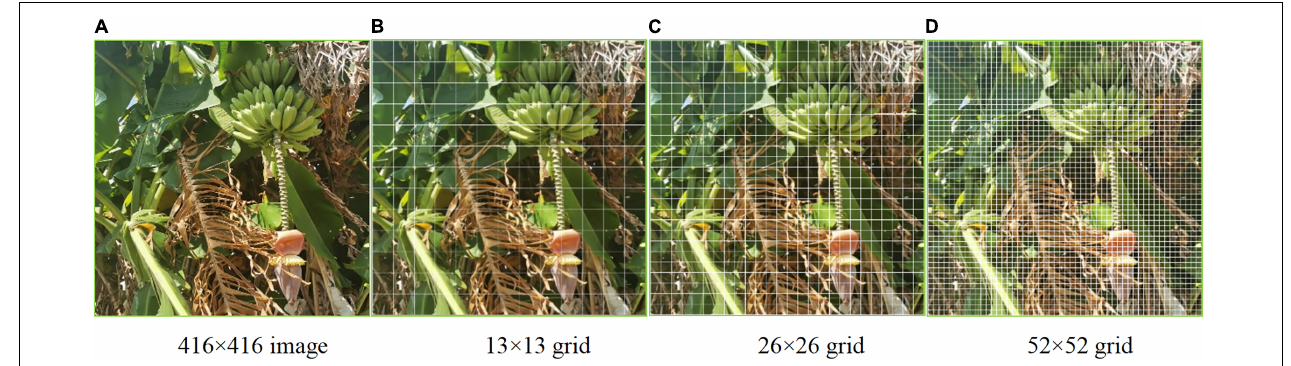
Here, the loss function was modified and improved. The network architecture is shown in Figure 4